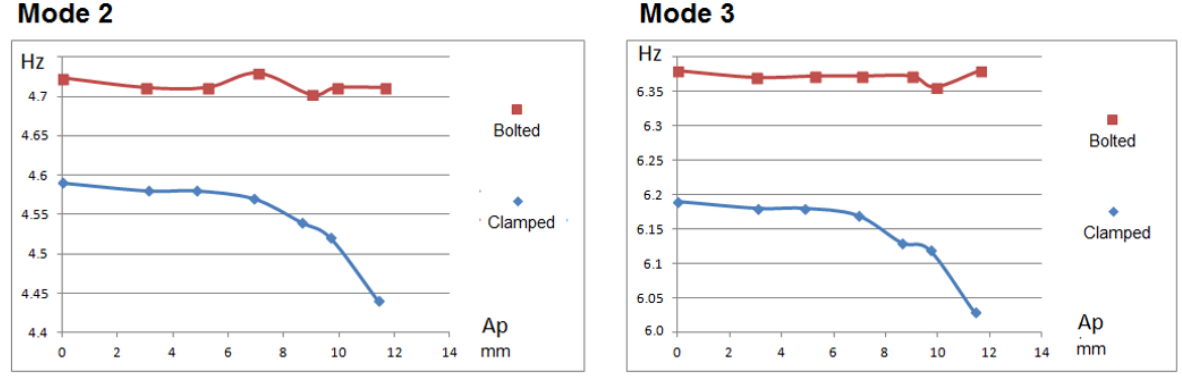
Figure 11. Variation of the frame ’ s natural frequencies after being subjected to different oscillation amplitudes at the top of the frame.